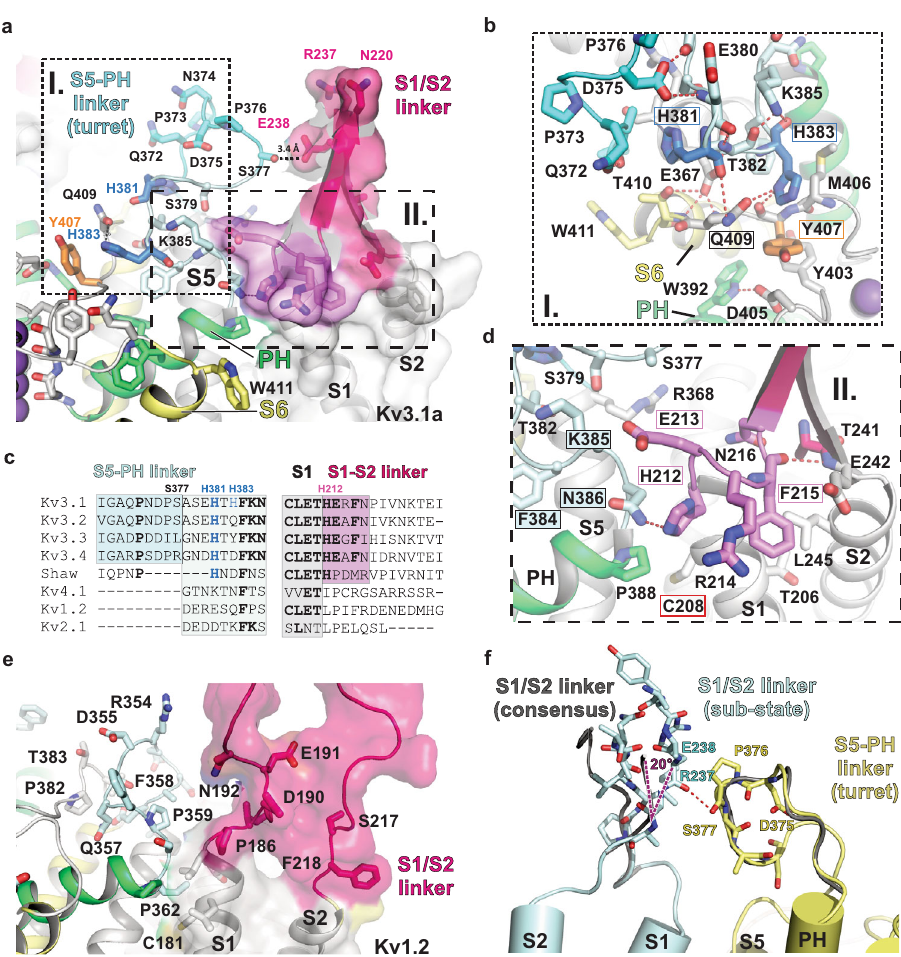
Fig. 8 Architecture of the turret domain of Kv3.1a and its interaction with the S1/S2 linker of the adjacent VSD. a Overview of the S5-PH linker region ( “ turret region ” , shown in shades of blue) and the interface between pore helix PH (green cartoon) and S1/S2 linker of the VSD (surface representation and pink cartoon). b Inset I from a : Detailed view of histidines H381 and H383 (bold blue sticks) in the turret domain and their interactions with Q409 in S6 (pale yellow) and Y407 (orange sticks) near the selectivity fi lter of the pore domain. c Sequence alignments of the S5-PH linker (left) and the S1/S2 linker region (right) for human Kv3 family members and other human T1-containing Kv channels, highlighting the enlarged turret domain unique to the Kv3 subfamily and the location of conserved Kv3-speci fi c histidines. Conserved residues are represented in bold letters. Coloured regions follow colour- coding in panels a , b , d . d Inset II from a : detailed view of the PD/VSD interface formed by residues at the N-terminal end of the S1/S2 linker of the VSD unique to Kv3 subfamily (pink ribbon) and their interactions with residues in the transition zone between the turret domain (light cyan) and the pore helix (PH in green). Red frame indicates the location of variant C208Y associated with non-progressive myoclonus epilepsy 12 . Pink frames and blue boxes highlight conserved residues in Kv3 channels. e View of the shorter S5-pore helix linker region of Kv1.2 ( “ turret region ” , shown in pale blue) and the interface between pore helix PH (green cartoon) and S1/S2 loop of the VSD (surface representation and cartoon in bold pink). f Alternative conformation of the S1/S2 linker (light blue cartoon representation) from a subset of particles obtained by 3D variability analysis in comparison to the consensus conformation (dark grey cartoon representation). The sub-state allows the formation of an H-Bond (red dashed line) to the backbone carbonyl of S377 in the turret domain (represented as yellow cartoon). Purple dashed lines illustrate the angle between the main conformation (consensus) and the sub-state of the S1/S2